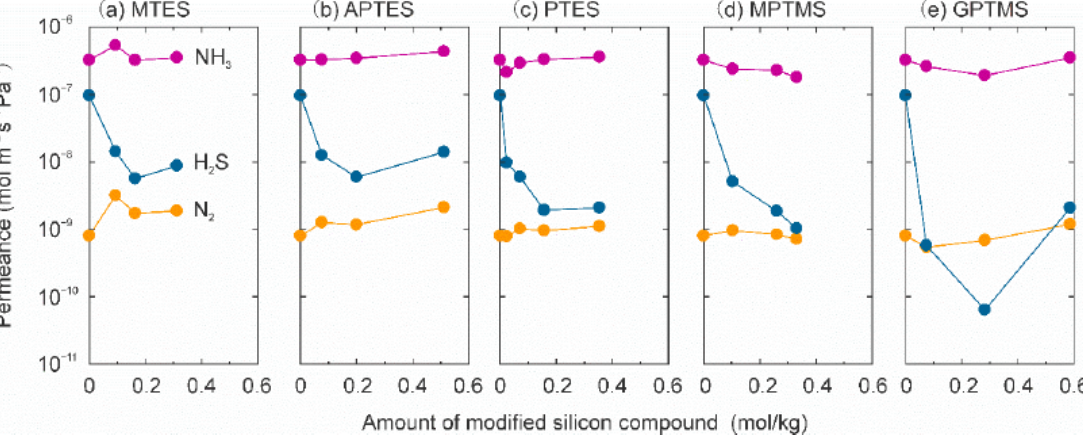
Figure 8. Effect of modification with silicon compounds on permeances of FAU-type zeolite membranes for ternary mixtures of NH 3 , H 2 S, and N 2 at 295 K. ( a ) MTES, ( b ) APTES, ( c ) PTES, ( d ) MPTMS, and ( e ) GPTMS.